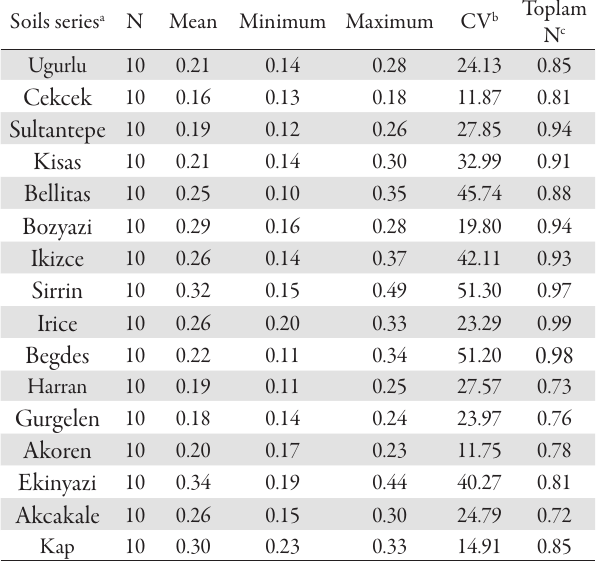
Tab. 5. Nitrogen content of Harran plain of soils (kg N m -2 )